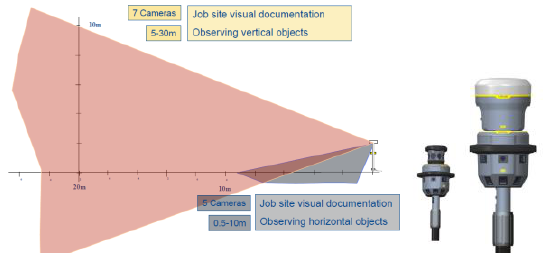
Figure 4. Vertical field of view of IR Trimble V10.